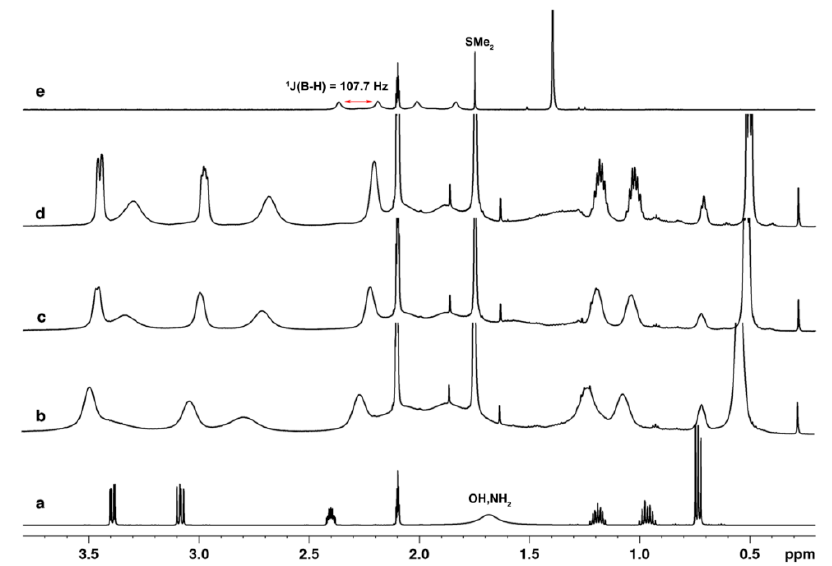
Figure 1. 1 H NMR spectra of: ( a ) pure ligand 2c (0.1 M) in toluene-d 8 , and mixture of 0.1 M of 2c and BH 3 •SMe 2 (1:1 molar ratio) in toluene-d 8 measured at different time intervals after sample preparation: ( b ) 15 min, ( c ) 4 h 30 min and ( d ) 4 days. The 1 H spectrum of BH 3 •SMe 2 in toluene-d 8 is also shown for comparison ( e ).